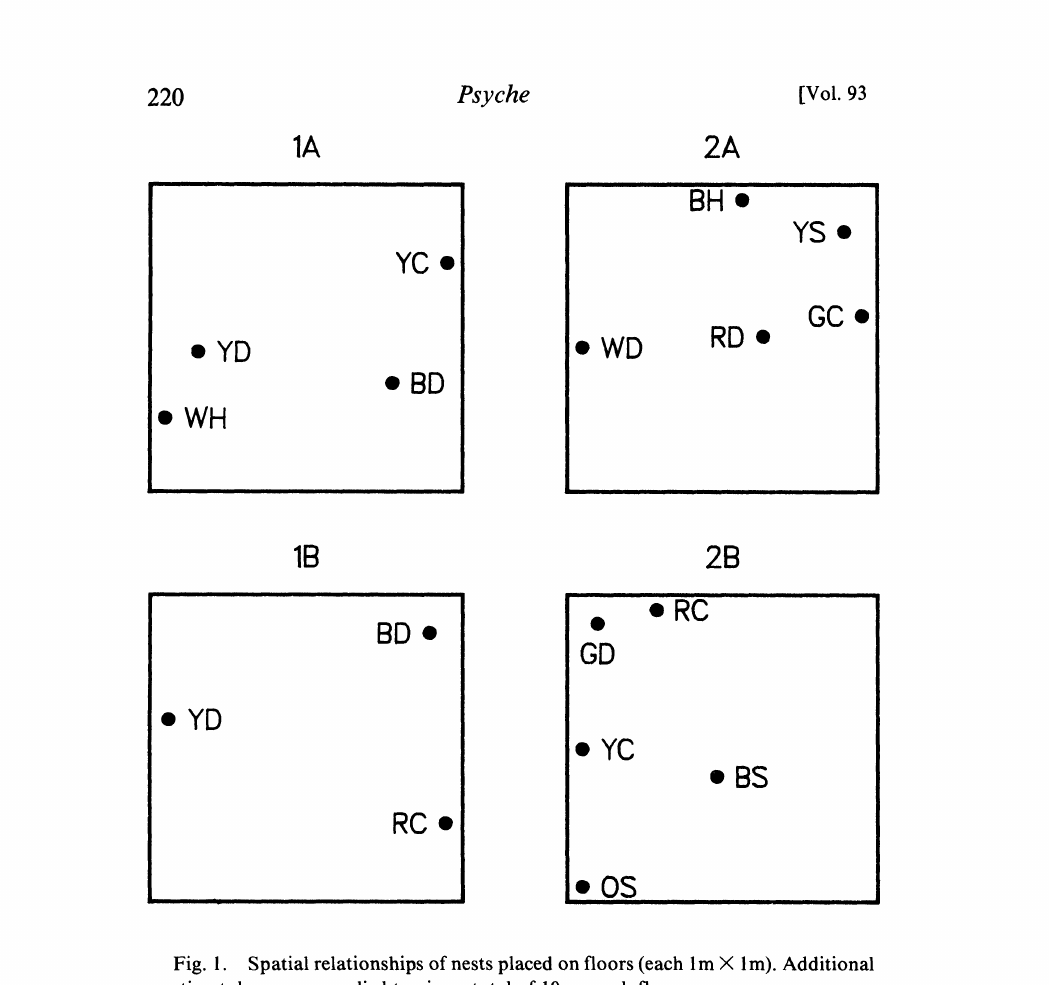
Fig. 1. Spatial relationships of nests placed on floors (each lm X lm). Additional nesting tubes were supplied to give a total of 10 on each